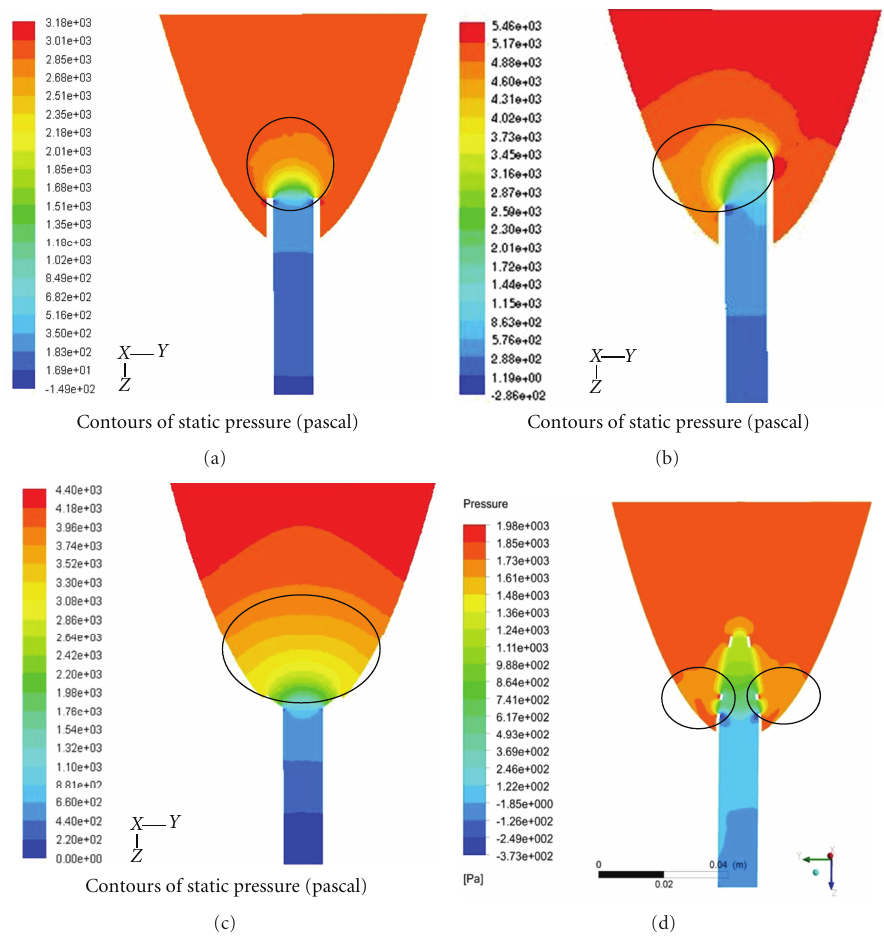
Figure 6: Contour of static pressure: (a) blunt, (b) beveled, (c) trumpet, and (d) caged.